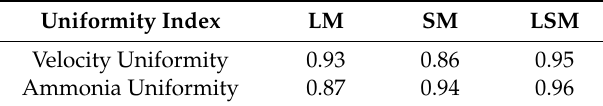
Table 3. Uniformity index at the inlet of the catalyst